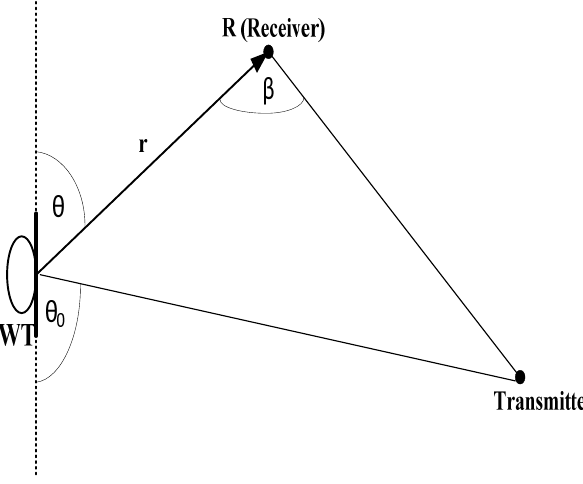
Figure 7. Plot outlook of the Draft New Rec. ITU-R model [49].